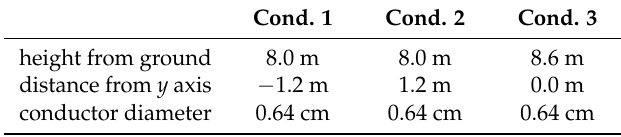
Table 1. Geometry of the MTL system.